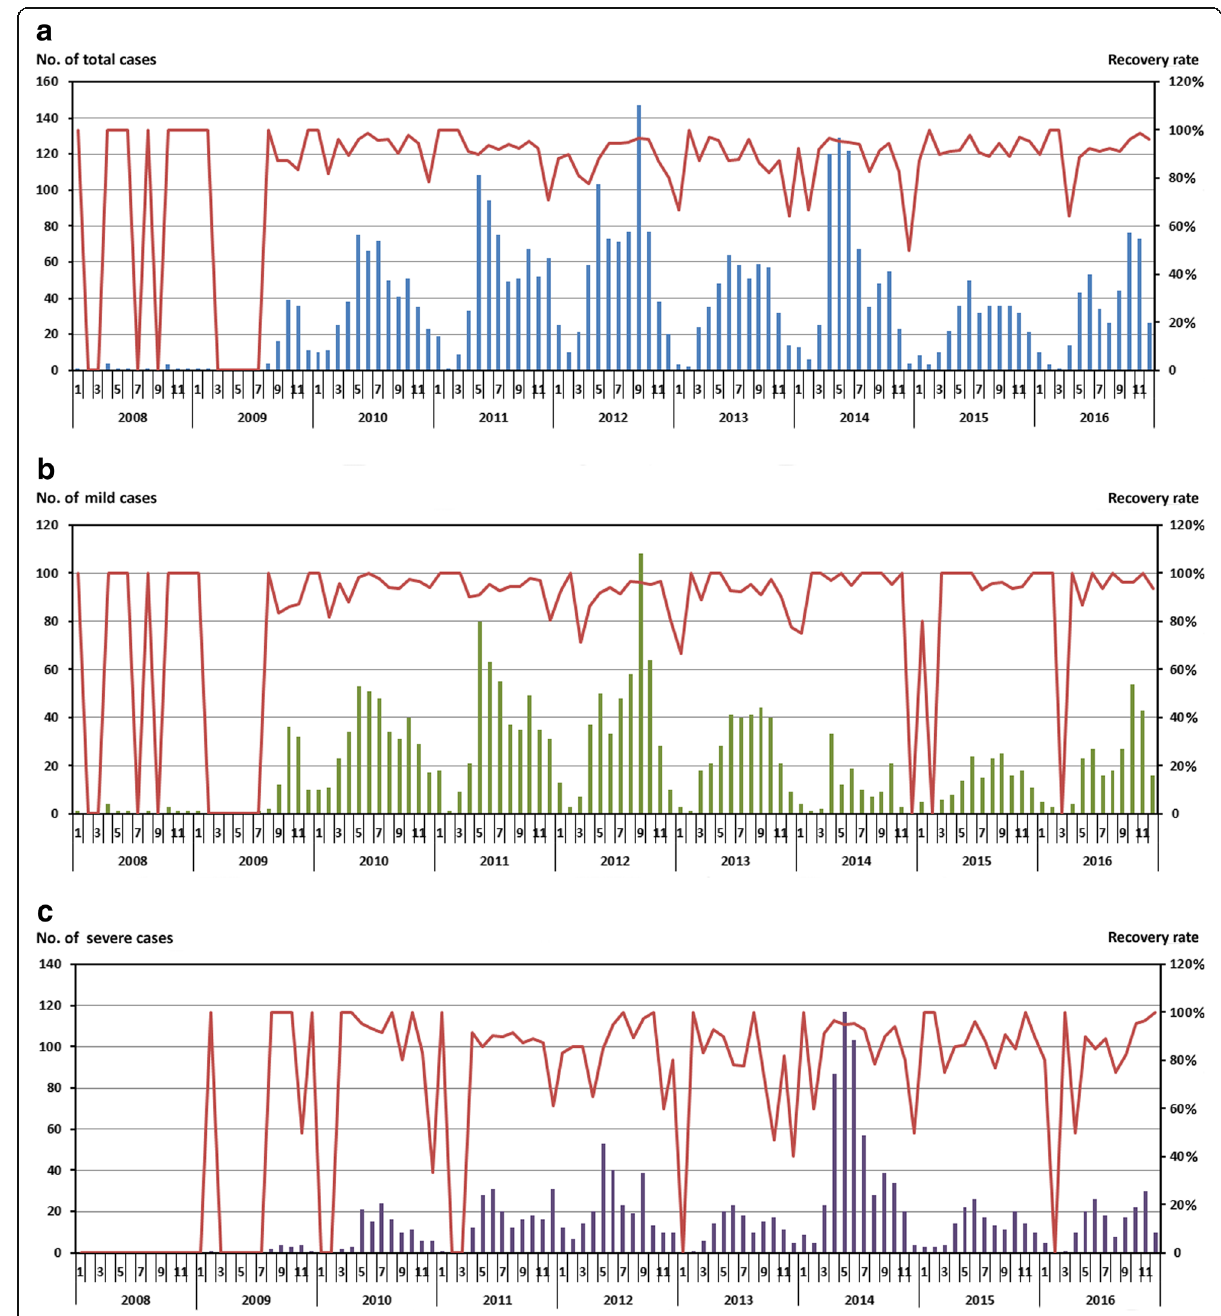
Fig. 1 Monthly incidence and recovery rates of HFMD during 2008 – 2016. Recovery is defined as clearance of fever, rashes, and CNS